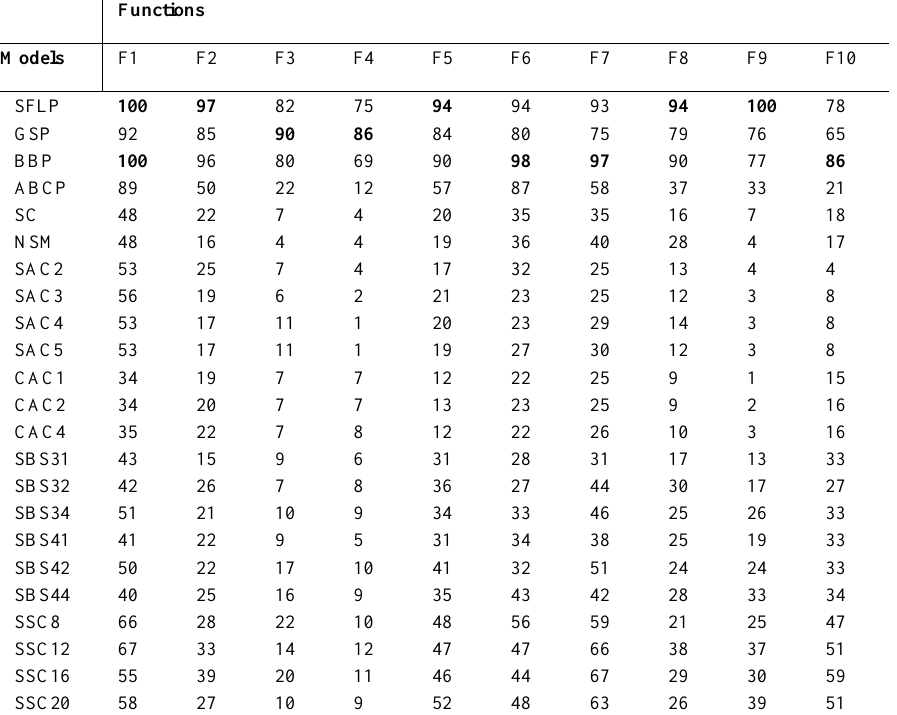
Table 4. Number of successful runs of SFLP and other considered models with parameter setting of 𝑵𝒔𝒕𝒆𝒑 = 𝟓𝟎, 𝒒 = 𝟐,𝒎 = 𝟏𝟎𝟎,𝒂𝒏𝒅 𝒏 = 𝟓.